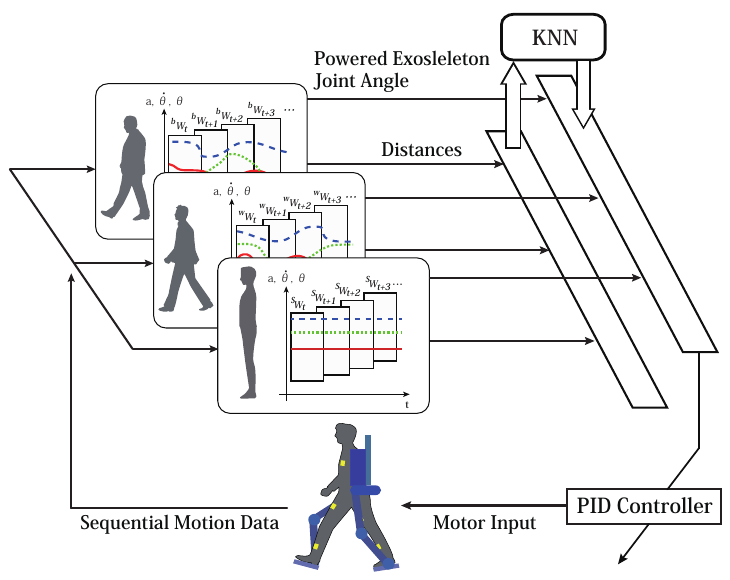
Figure 4. Overview of proposed control